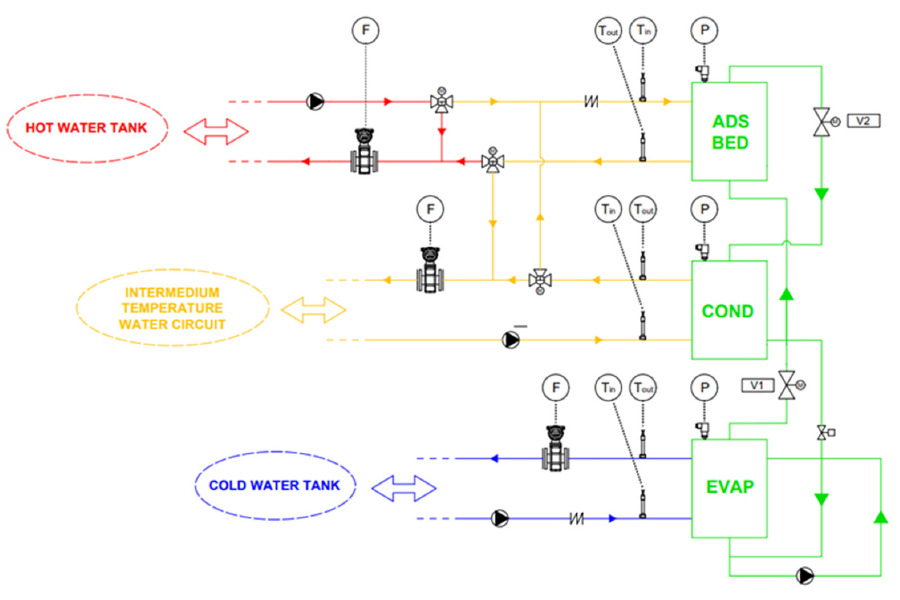
Figure 3. Hydraulic and vacuum circuits scheme (F = flow meter, T = thermo-resistance, P = pressure transducer). Table 2. Sensors’ range and accuracy.